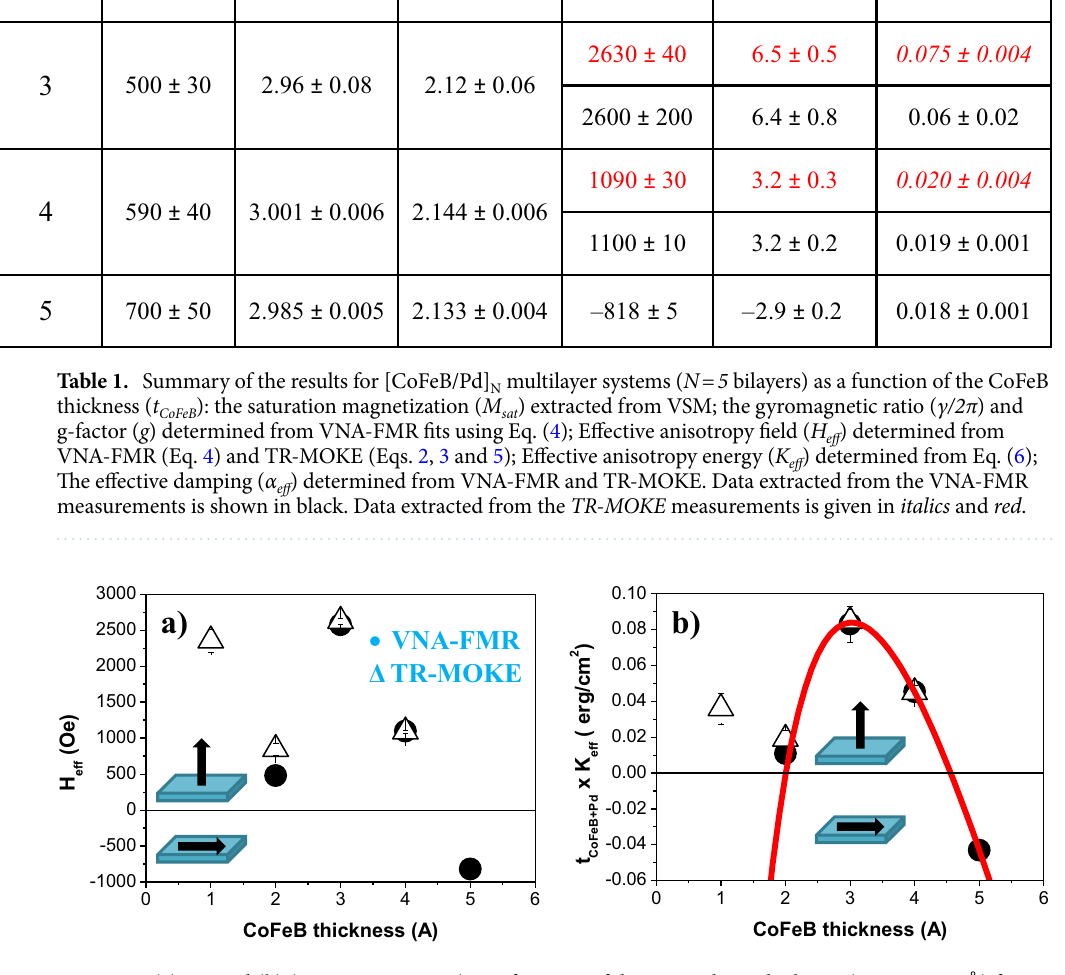
Figure 4. ( a ) H eff and ( b ) ( t CoFeB + Pd × K eff_CoFeB ) as a function of the CoFeB layer thickness ( t CoFeB = 1 – 5 [CoFeB ( t CoFeB )/Pd (10 )] 5 multilayer thin films. While black open circle are the experimental data determined from the VNA-FMR measurements, black open triangle were determined from the TR-MOKE studies. The red Å solid line in ( b ) is the fitting to the model described by Eq.